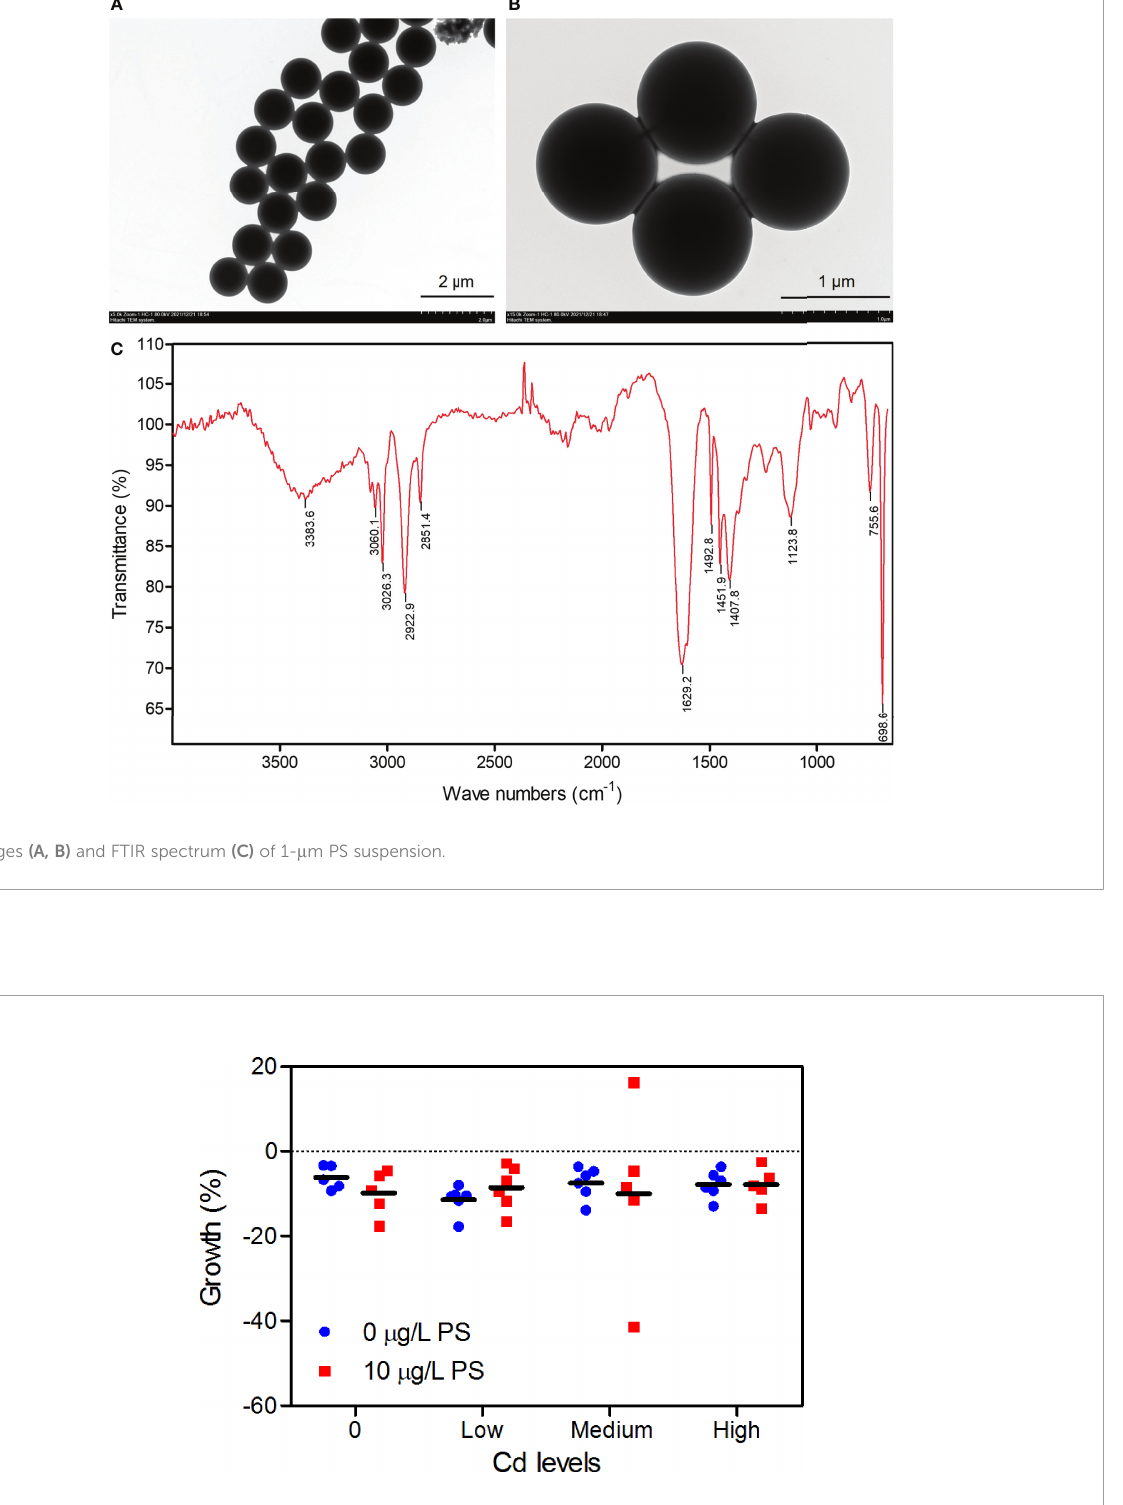
FIGURE 2 Growth (weight change percent) of P. aibuhitensis after 7 days of exposure to Cd alone and Cd combined with 10 m g/L of PS. Results are presented as scatter plot ( n = 5 – 6) and mean (black bar).